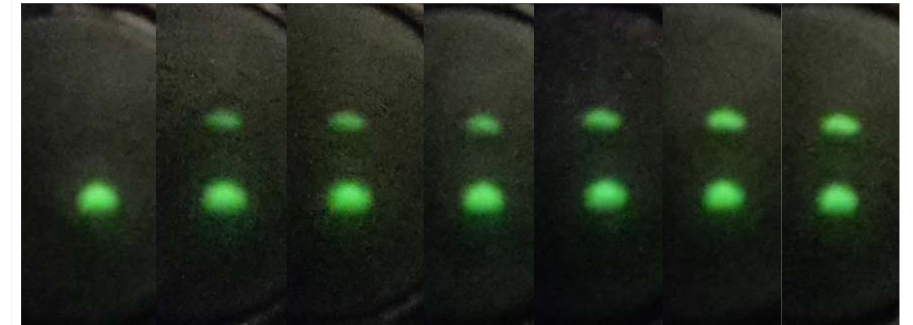
Figure 4. Visual monitoring of neutral beam production. The undetached ions are deflected by an electric field weak enough not to send them out of the detector, leading to simultaneous observation of both the ion (below) and neutral (above) beams. The beams are offset by 6.2 mm. The intracavity light power was 0, 1.3, 1.45, 2, 3, 6.5 and 11.5kW (it being understood that the ions cross twice a beam of that power), from left to